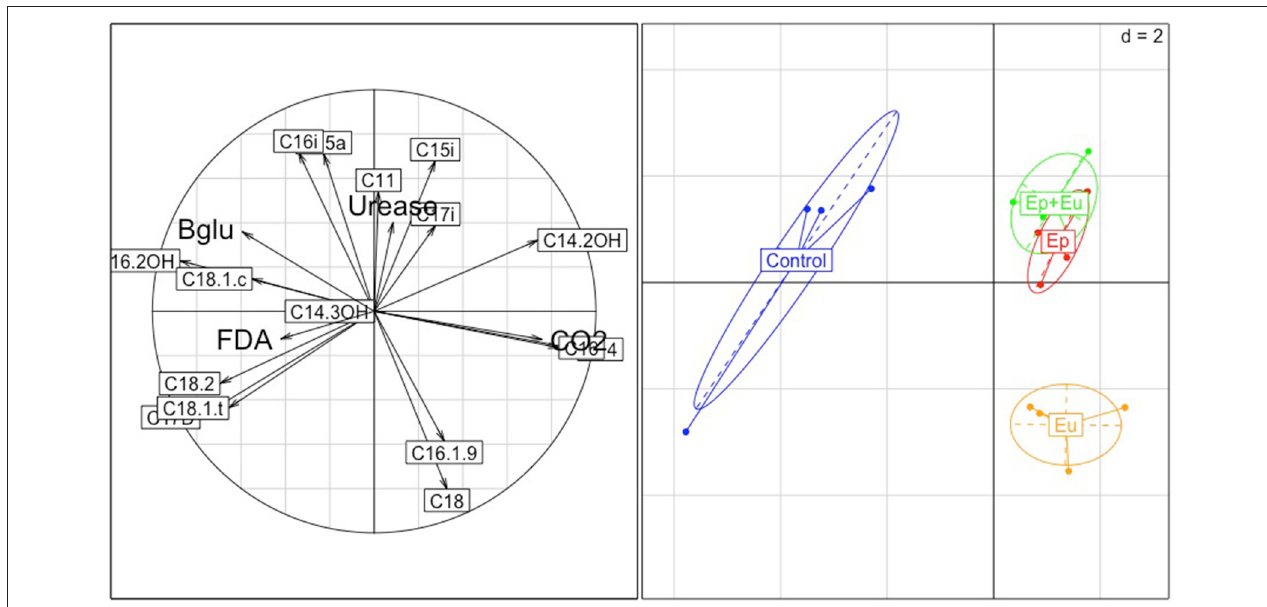
FIGURE 5 | Principal Component Analysis (PCA) of soil microbial parameters during the second month after Collembola re-inoculation. Correlation circle with the variables is on the left; and projection of the treatments on the right. Control, without Collembola; Ep, Epedaphic Collembola; Eu, Euedaphic Collembola; Ep + Eu, mixed functional groups; FDA, FDA activity; Urease, Urease activity; CO2, CO 2 activity.